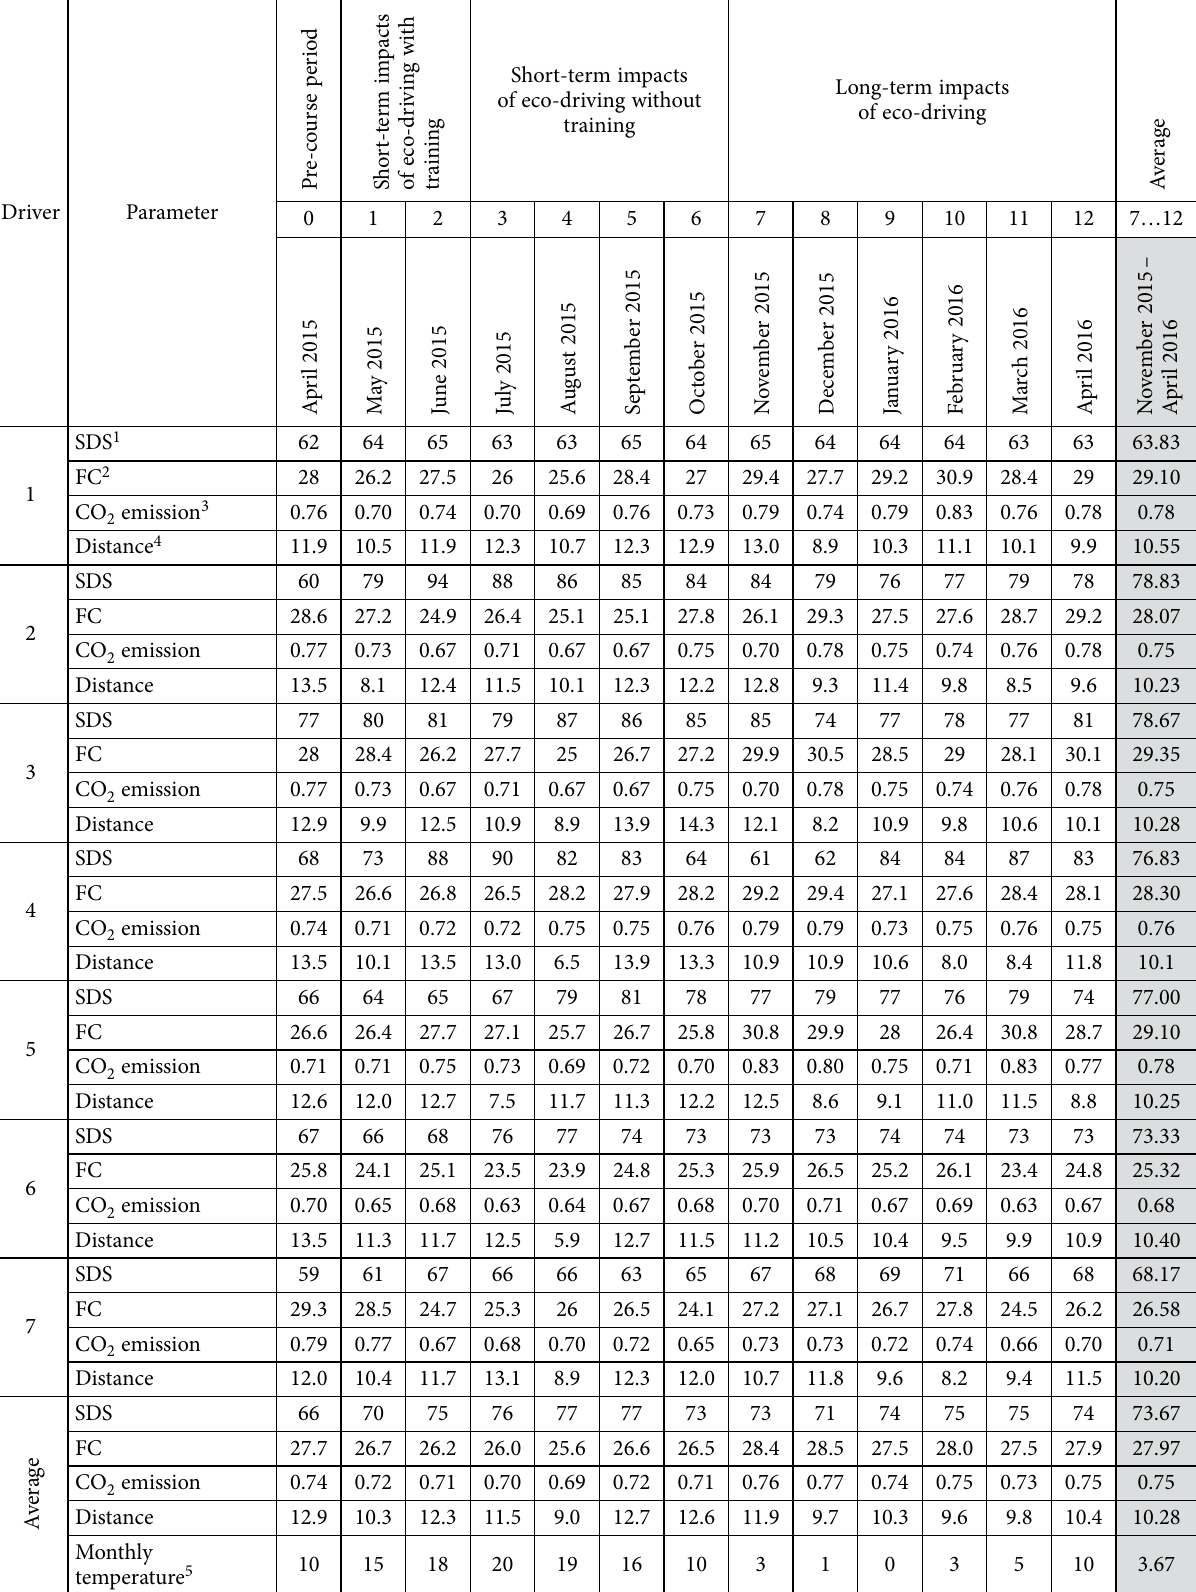
Table 2. Sum of research data before and after eco-driving training